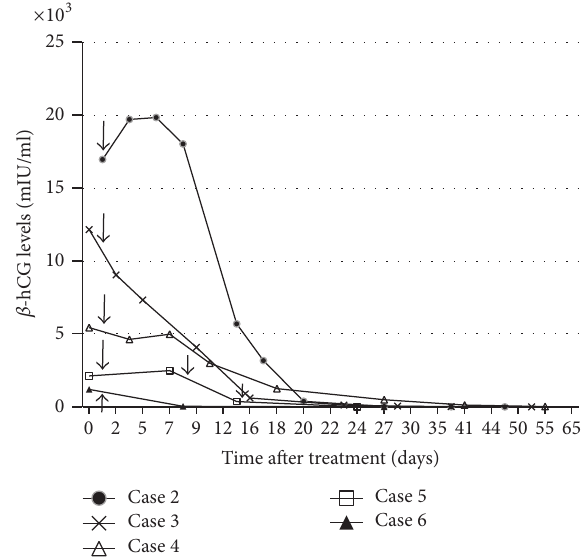
Figure 2: Curve of serum 𝛽 -hCG levels for cases 2–6. Arrow indicates MTX